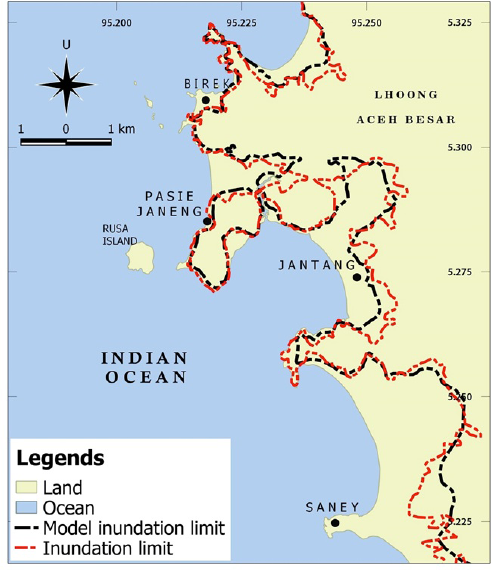
Figure 4. The 2004 tsunami inundation limit at Lhoong based on the numerical simulation (dashed black lines) and satellite image digitization (dashed red